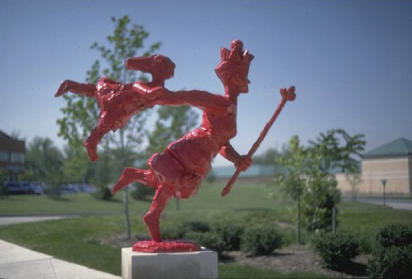
The Red Queen hypothesis posits that sex allows hosts to evade co-evolving parasites. (Photo: William F. Duffy)